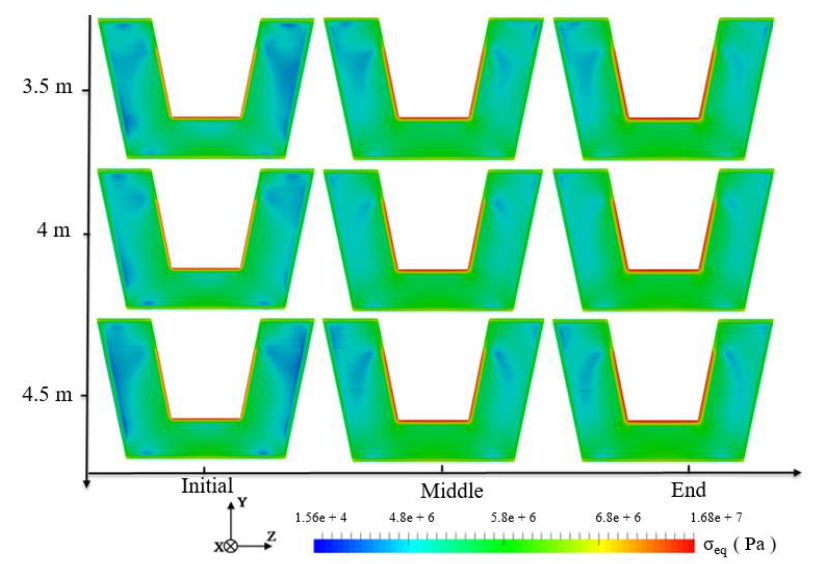
Figure 11. Equivalent stress distribution on the cross-section of the main trough at different times. Eight straight inspection lines were selected on the bottom of the main trough,